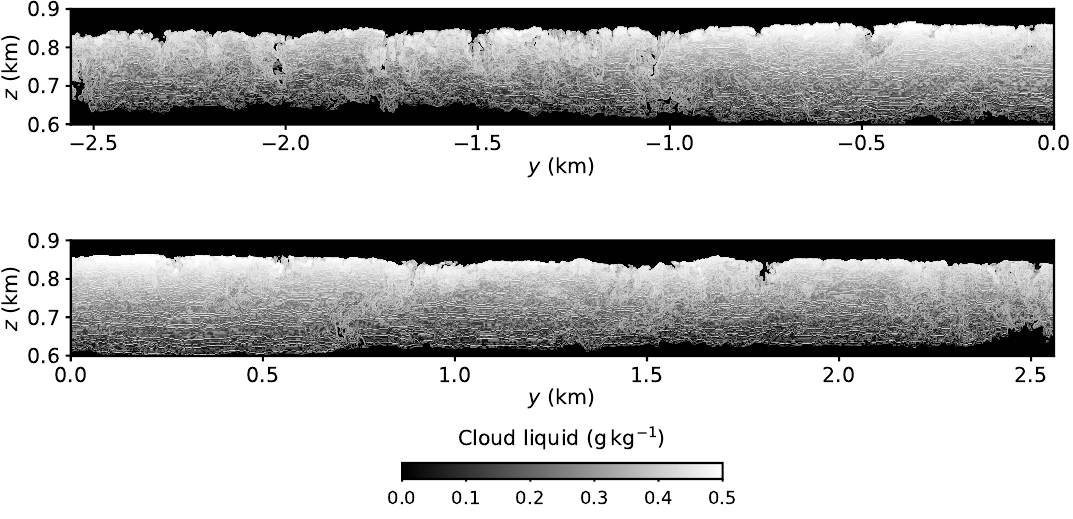
Figure 6. Cloud liquid mixing ratio on a vertical plain at x = − 1 km for Case A1. The elongated domain is partitioned into two panels. Only the cloudy region is shown. Evaporative cooling at the cloud top creates clear-air slits near the cloud top.